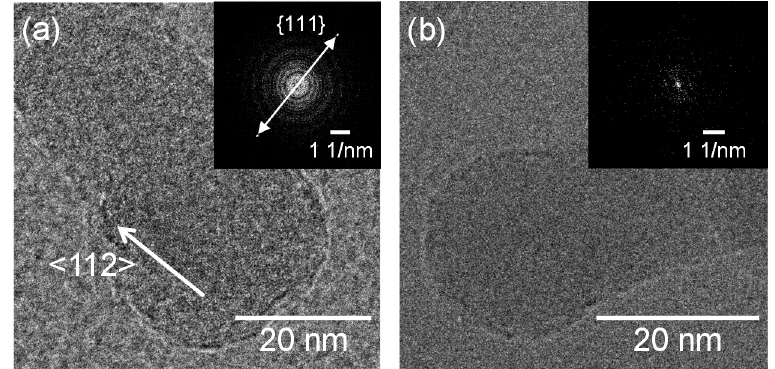
Figure 10. TEM images of silicon nanofibers generated from sludge preheated at ( a ) 400 and ( b ) 900 °C.